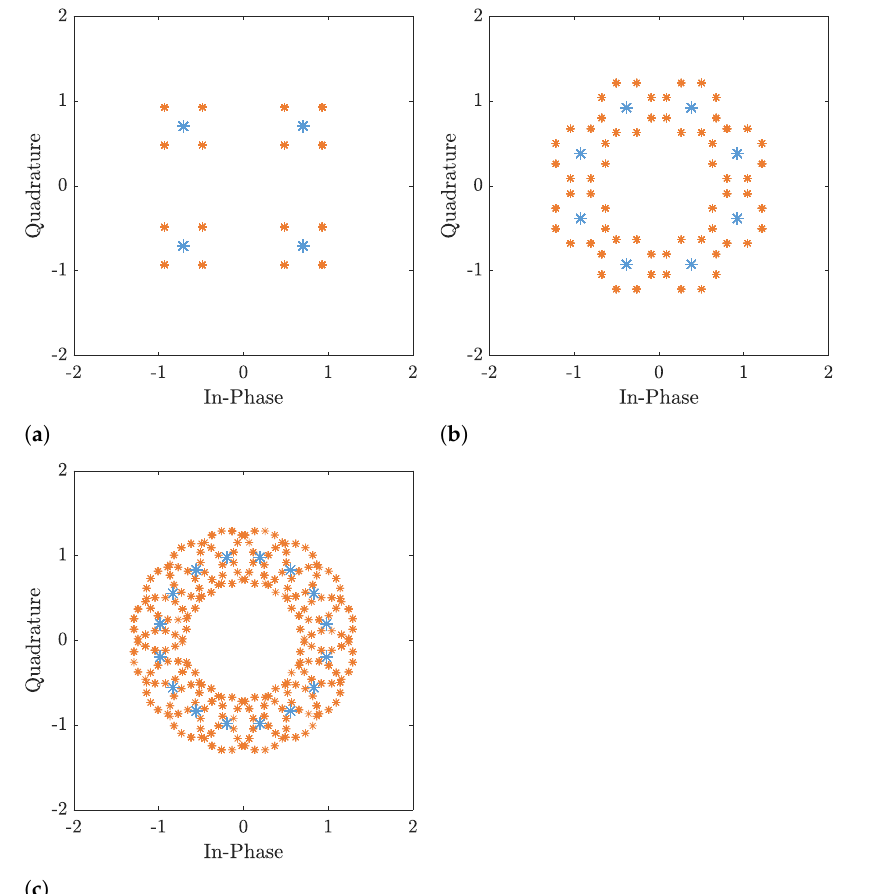
Figure 8. A constellation of transmitted symbols (blue) and received symbols in the presence of the smart jammer (orange), for ( a ) 4–PSK, ( b ) 8–PSK, ( c ) 16–PSK modulations, no AWGN, and SIR = 10